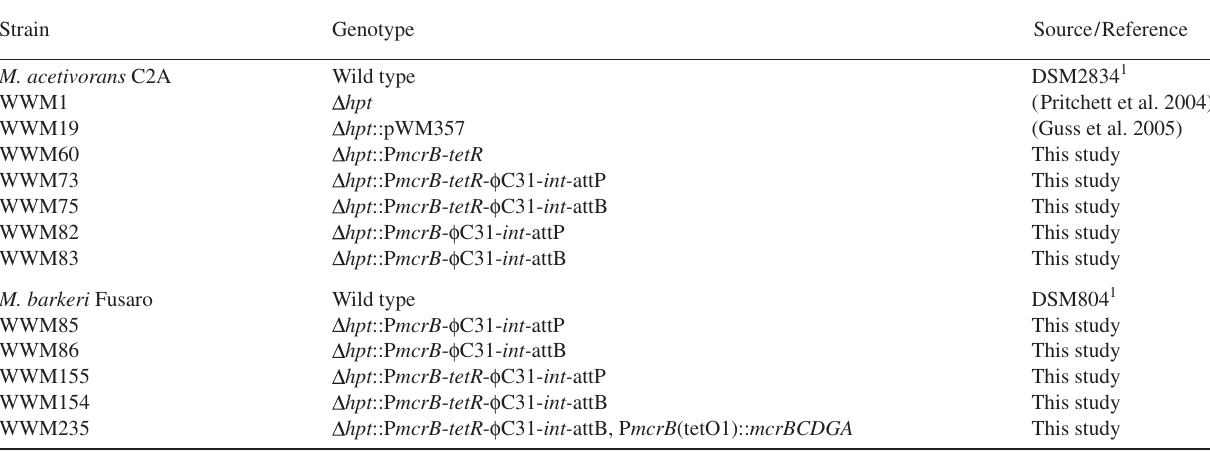
Table 1. Methanosarcina strains used in this study.